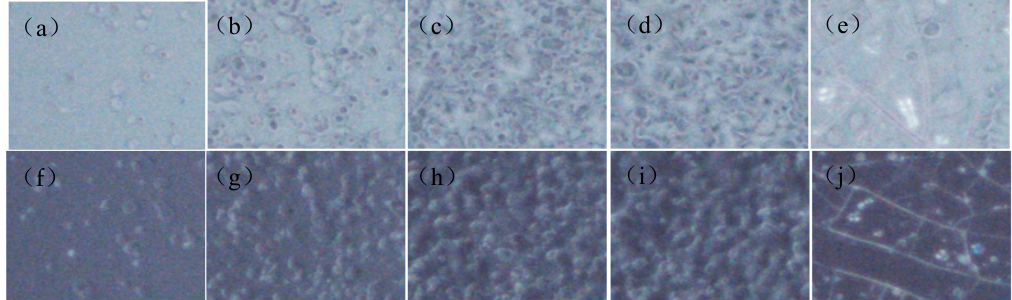
Figure 4. The digital microscope pictures of microstructure morphology of anti-glare samples by different sol-gel deliver pressure: ( a ) 60 kPa (90 ◦ ); ( b ) 120 kPa (90 ◦ ); ( c ) 210 kPa (90 ◦ ); ( d ) 300 kPa (90 ◦ ); ( e ) 600 kPa (90 ◦ ); ( f ) 60 kPa (25 ◦ ); ( g ) 120 kPa (25 ◦ ); ( h ) 210 kPa (25 ◦ ); ( i ) 300 kPa (25 ◦ ); and ( j ) 600 kPa (25 ◦ ) with air transport pressure and displacement speed of 300 kPa and 300 mm/s, respectively.